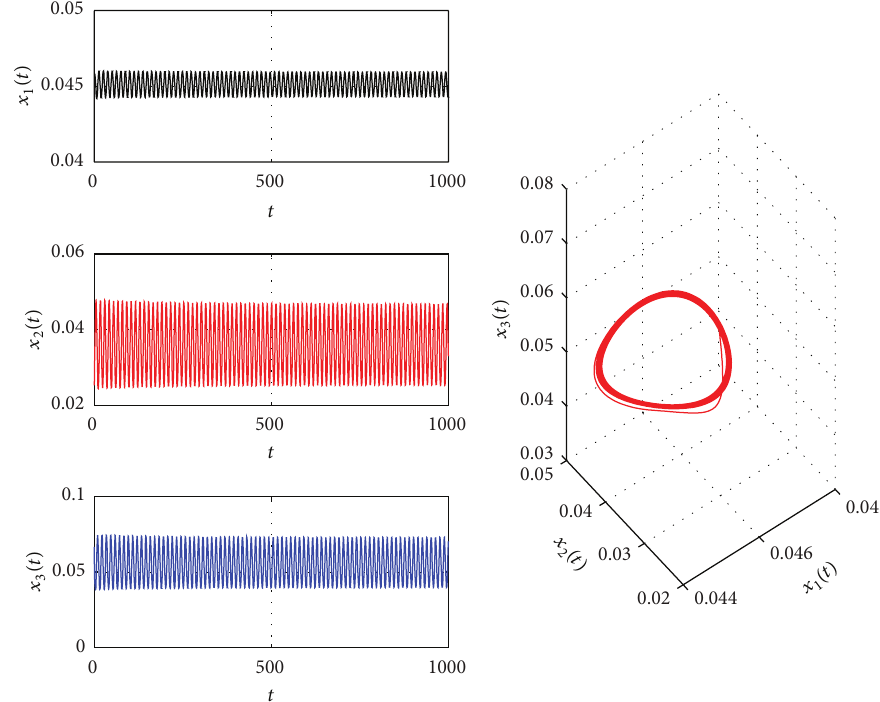
= 3.2348 ; a periodic orbit bifurcate from 𝐸 0